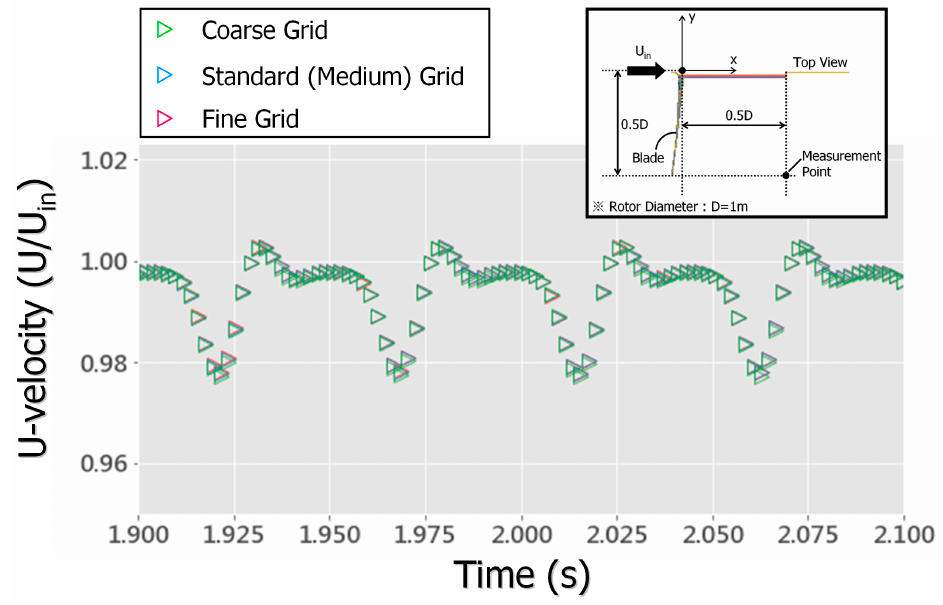
Figure 13. Comparison of the change in time of the instantaneous U-velocity at the measurement = 0.5D, y = − 0.5D) indicated by the black circle symbol in Figure point (x = 0.5D, y = − 0.5D) indicated by the black circle symbol in Figure 9a. (x